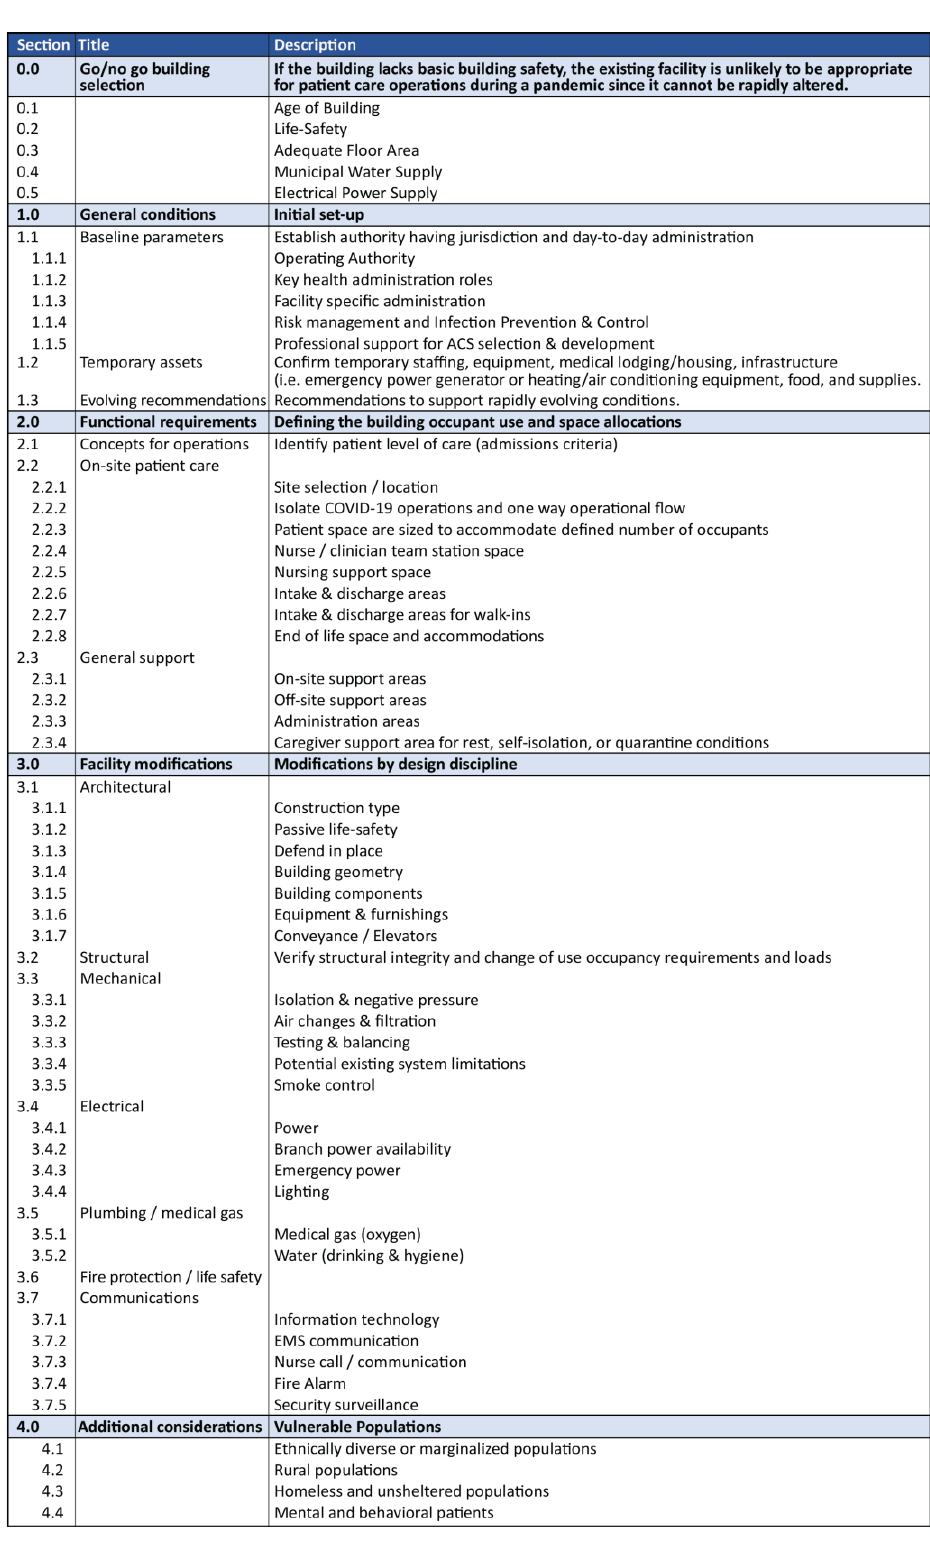
Figure 3. COVID-19 ACS Preparedness Assessment Tool Outline